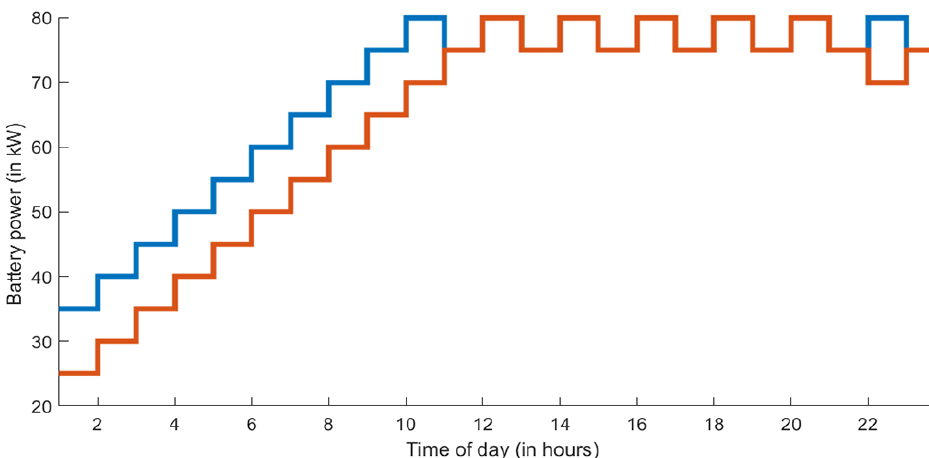
Figure 8. Change of BESSs’ power state for 24 h.